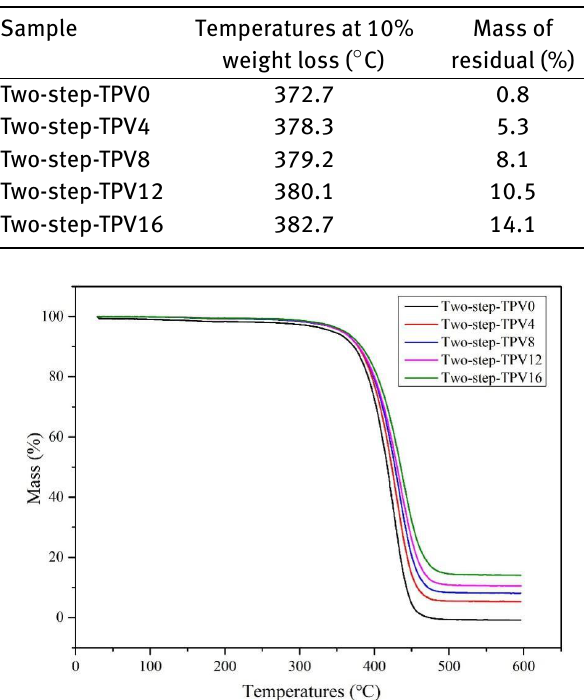
Figure 4: Resistivity of TPV with/without modification plotted versus CB content.